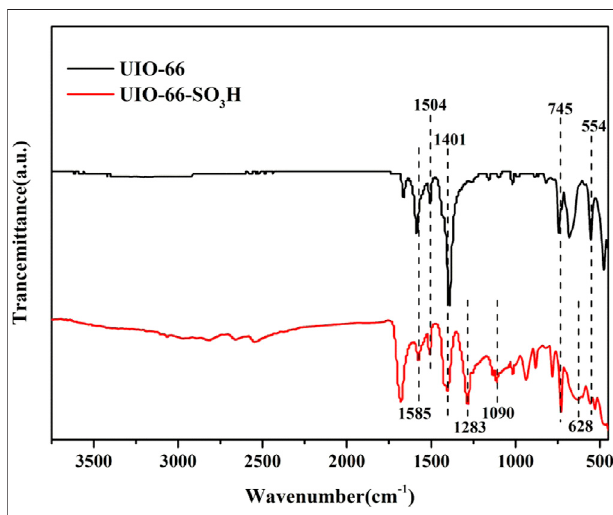
FIGURE 2 | FT-IR spectra of UIO-66 and UIO-66-SO 3 H.